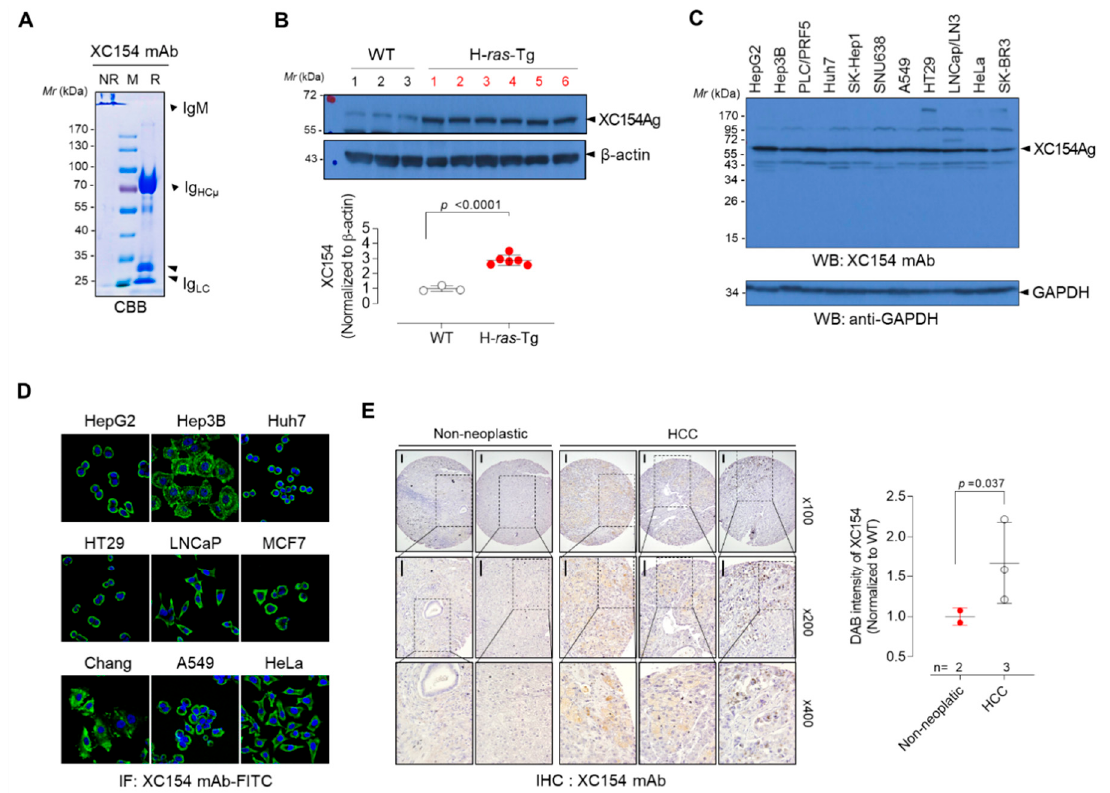
Figure 1. Tumor-associated autoantibody XC154mAb was identified in human (HCC) model HBx-Tg mouse. ( A ) SDS-PAGE analysis of purified XC154 mAb. Purified XC154 mAb (10 µ g) was treated with non-reducing (NR) or reducing (R) SDS-PAGE sample bu ff er and separated on 10% SDS-PAGE gel. Coomassie blue stained gel showed high molecular weight IgM and µ heavy chain with molecular weight of 72 kDa. M: molecular weight marker. ( B ) The expression of XC154 Ag in liver tissues of H- ras 12V-Tg mice. The liver tissue lysates (50 µ g) of wild-type mice ( n = 3) or tumor-bearing H- ras 12V-Tg mice ( n = 6) were separated on 10% SDS-PAGE and Western Blots were probed with XC154 mAb. Band intensities were quantified by Image J software and the values were normalized to β -actin. ( C ) Expression of XC154 antigen in various human tumor cell lines (cell lysates 40 µ g) shown by Western blotting. GAPDH was served as an internal control. Arrows indicate the XC154 antigen. ( D ) Immunofluorescent staining of tumor cell lines with XC154 mAb (0.5 µ g / mL) and FITC-labeled anti-mouse IgG. ( E ) Immunohistochemical staining of human liver tissues (non-neoplatic or HCC tissue) microarray with XC154 mAb (0.5 µ g / mL). DAB intensities were quantified by Image J software and the relative values were plotted. Statistical significance was determined by two-tailed Student’s t -test.